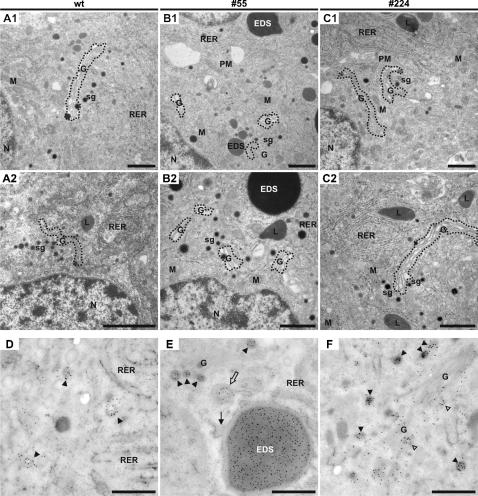
Electron microscopy analysis of wild-type and transgenic melanotrope cells.(A–C) Wild-type (wt; A1 and A2) intermediate pituitary cells showed a well-developed rough endoplasmic reticulum and extensive Golgi-ribbons. The p24α3-transgenic cells (#55; B1 and B2) contained Golgi mini-stacks and large electron-dense structures (EDS). The p24δ2-transgenic cells (#224; C1 and C2) showed an ultrastructure similar to that of wild-type cells. The dotted lines highlight the outline of the Golgi. (D–F) Immuno-electron microscopy analysis of intermediate pituitary melanotrope cells from wt frogs (D), and frogs transgenic for p24α3 (#55; E) or p24δ2 (#224; F) using an anti-POMC antiserum. Immunoreactivity was found in dense-core secretory granules (filled arrowheads) in wt and p24α3- and p24δ2-transgenic cells and occasionally in newly forming secretion granules still attached to the trans-Golgi network (open arrowheads). In addition, in the p24α3-transgenic cells a strong POMC-immunolabeling was observed in the EDS, which were localized to the ER lumen (arrow) and occasionally in EDS newly forming within the ER lumen (open arrow). G, Golgi; L, lysosome; M, mitochondrion; N, nucleus; RER, rough endoplasmic reticulum; PM, plasma membrane; sg, immature secretory granules. Bars equal 1 µm (A–C); 500 nm (D–F).